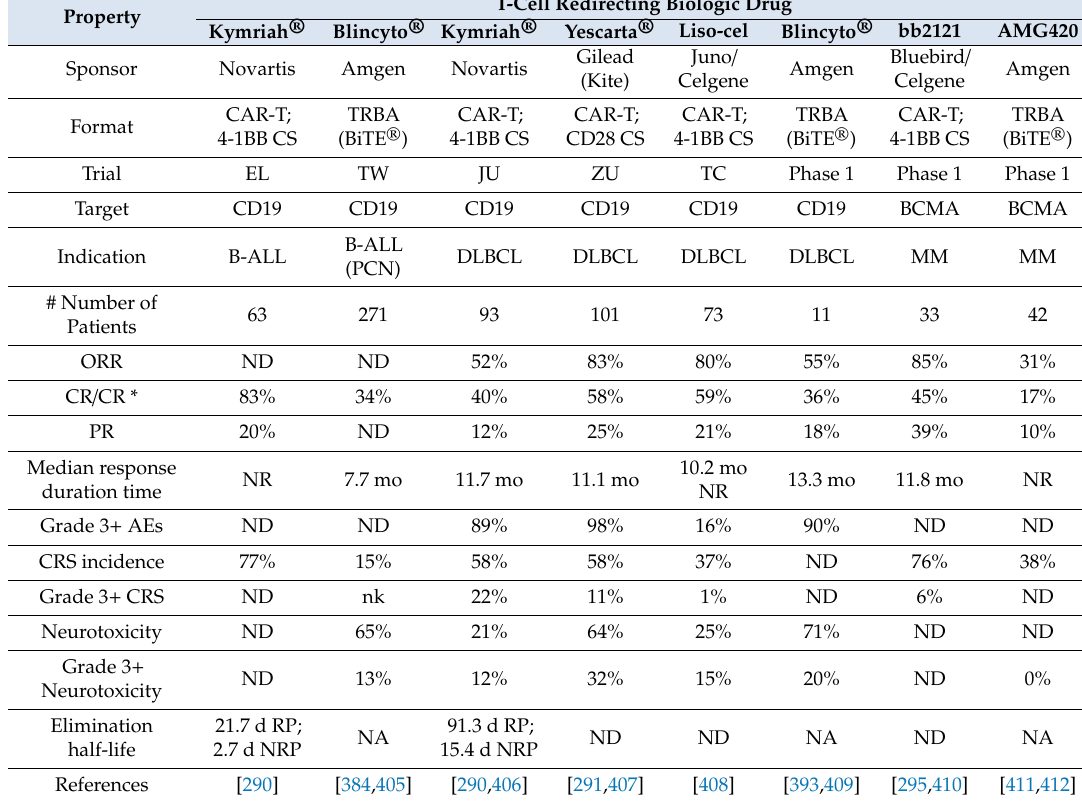
Table 7. Examples of clinical data with T-cell redirecting